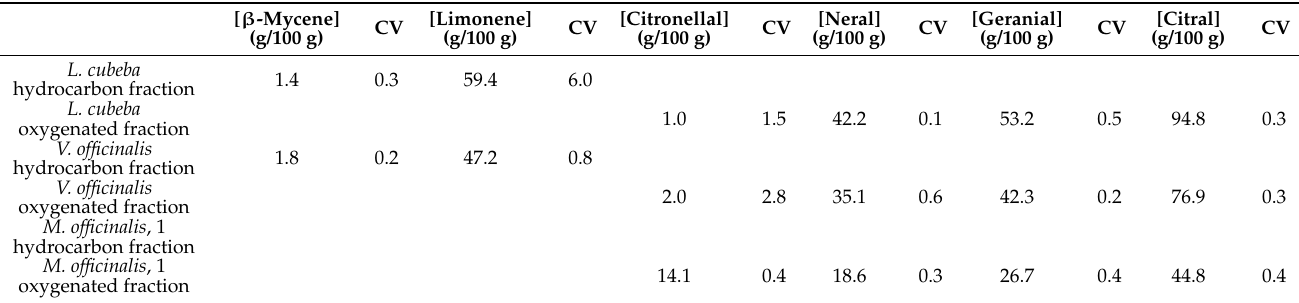
Figure 3. Comparison of the percentage of experimentally measured enzymatic inhibition and the enzymatic inhibition expected with citral as the only bioactive compound in the essential oils. Legend: Cs: Cymbopogon schoenanthus (batch 2020); Lc: Litsea cubeba (batch 2020); Mo,1: Melissa officinalis 1; Mo,2: Melissa officinalis 2; Mo3: Melissa officinalis 3; Vo: Verbena officinalis (batch 2020). Table 6. Concentration of selected bioactive compounds in the oxygenated and hydrocarbon fractions of the fractionated essential oils.